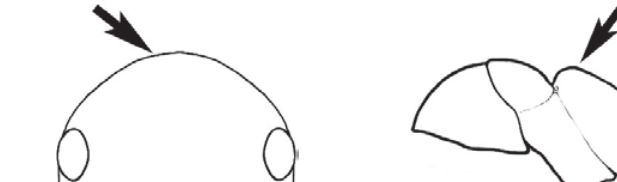
Minor and media worker with slight medioccipital protuberance (best seen in full-face view with head tilted down slightly); pronotum and gaster of all workers with appressed setae overlapping or at least much closer to neighbouring setae than their own length; in profile, propodeum of minor worker with flattened, elongate dorsum, a barely discernible propodeal angle and often a sharp anterior peak (arid and semi-arid) ( JDM 304 ) (Fig. 18a–g) .............................